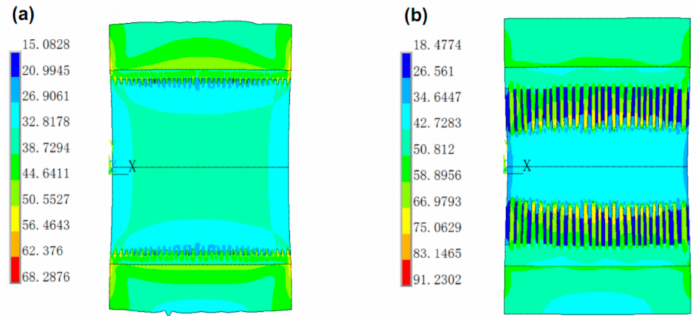
Figure 9. von-Mises stress (in MPa) contour plot for micro-joints with ( a ) 20% and ( b ) 40% IMCs under tensile loading. (For interpretation of the references to color in this figure legend, the reader was referred to the web version of this